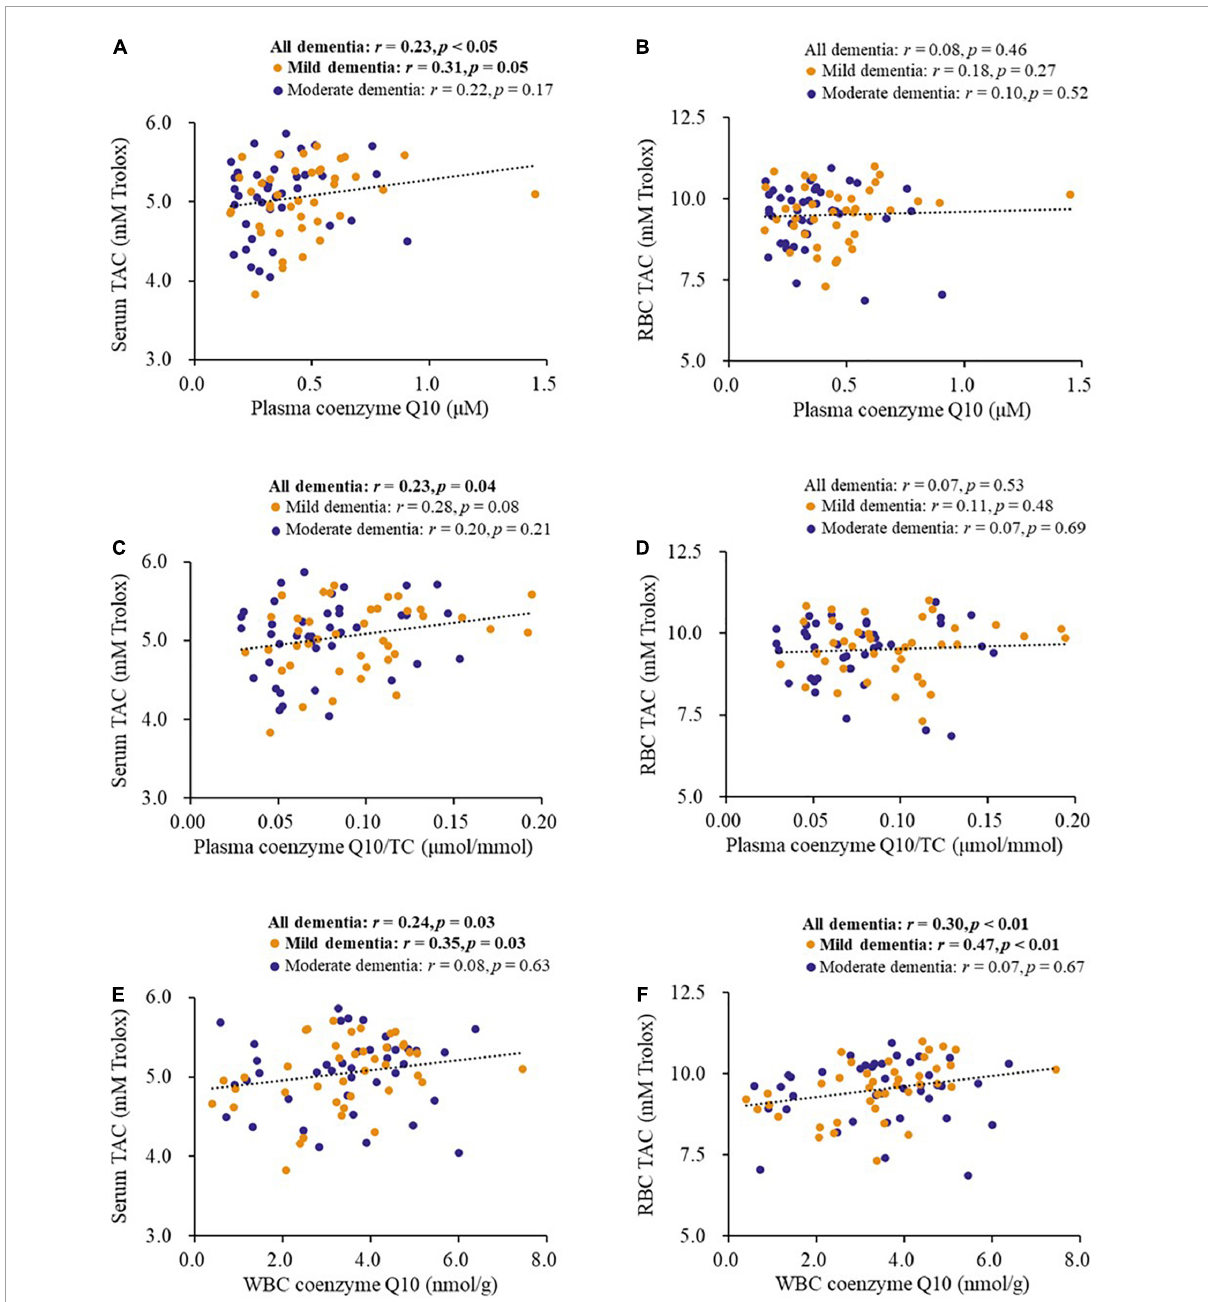
FIGURE2 Correlations between coenzyme Q10 status and antioxidant capacity of patients. (A,B) Correlations between the level of plasma coenzyme Q10 and antioxidant capacity. (C,D) Correlations between the level of plasma coenzyme Q10/TC and antioxidant capacity. (E,F) Correlations between the level of WBC coenzyme Q10 and antioxidant capacity. CoQ10, A β , Tau in